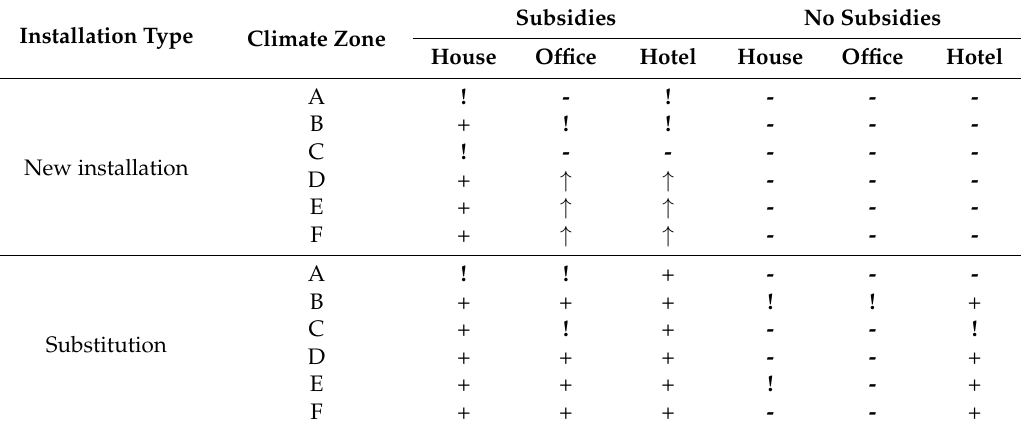
Table 6. Economic feasibility of GCHP system installation in different buildings at actual energy prices. (-, not feasible investments; ! , investments with low internal rate of return; +, feasible